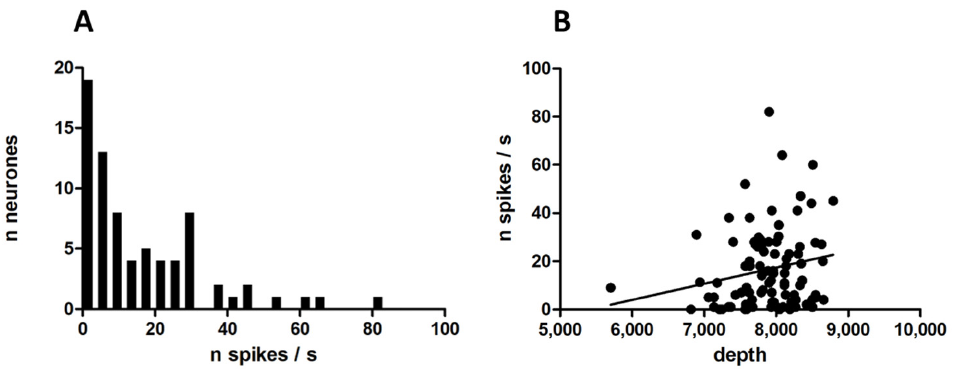
Figure 1. Effects of food odour on single neuronal recordings in the ventral striatum. ( A ). Number of neurones as a function of spontaneous activity (bin width: 4 spikes/s). Median, 11 spikes/s, range, 0–82 spikes/s. ( B ). Relation between spontaneous activity (spikes/s) and depth of recording (micrometers). Each point displays the mean spontaneous activity of a neurone plotted versus the depth under the cortical surface at which it was recorded. There was no correlation between these 2 variables.